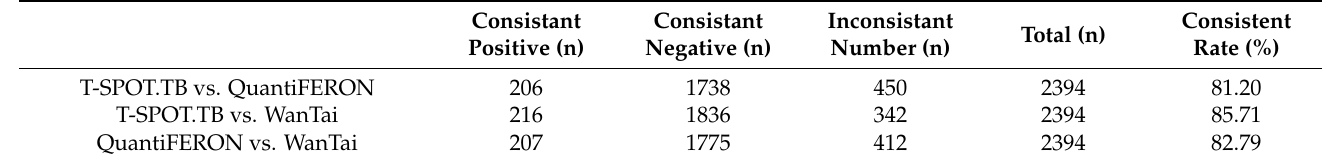
Table 1. The consistency between T-SPOT.TB, QuantiFERON, and